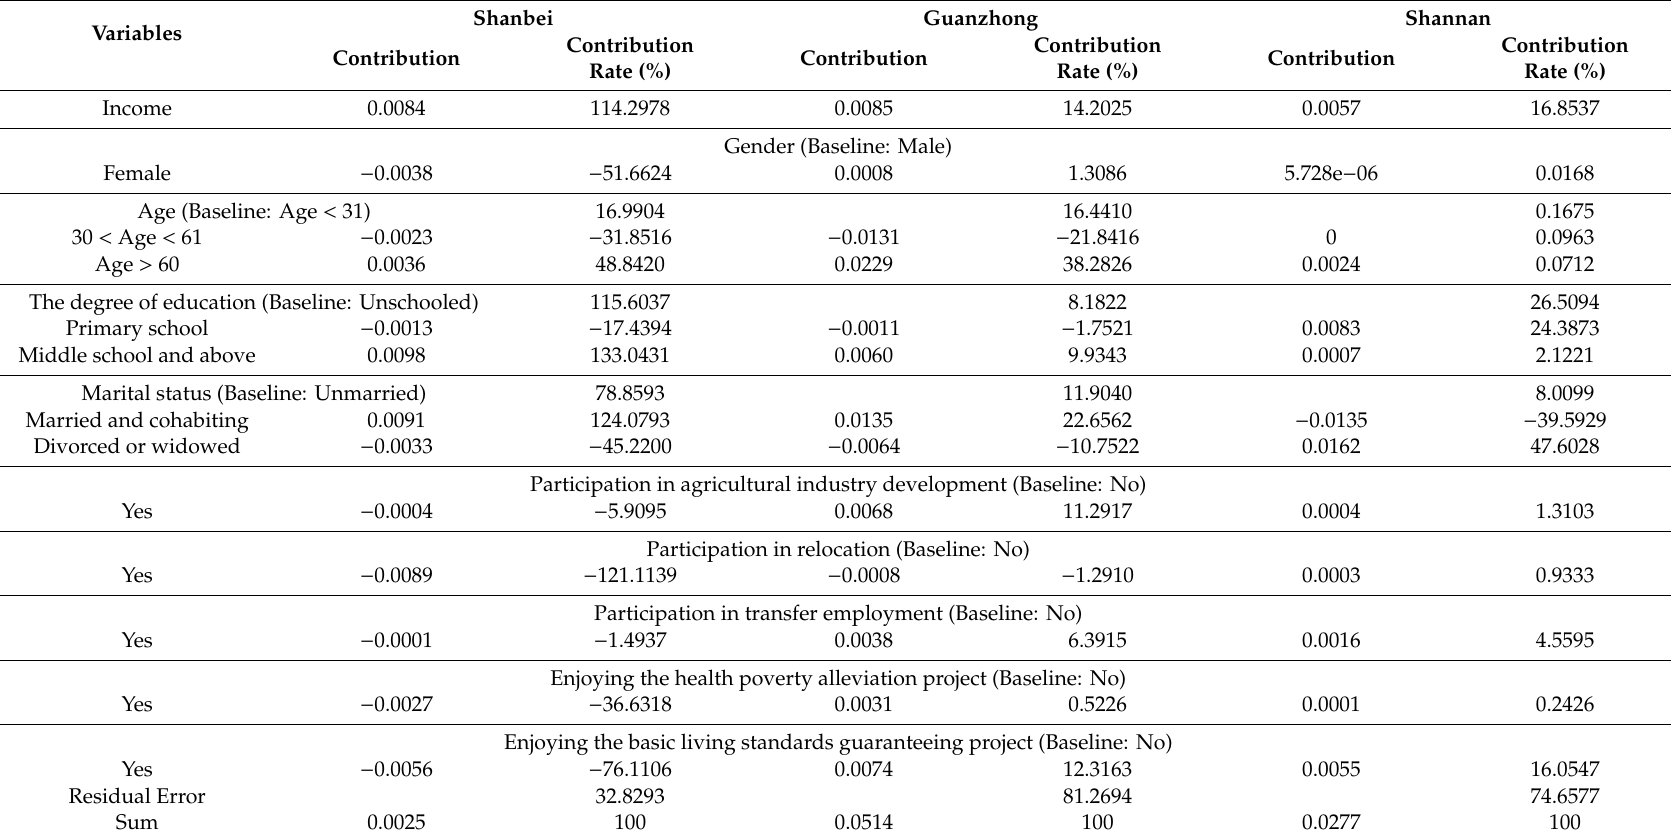
Table 6. Decomposition of health inequity of the rural poor residents in di ff erent